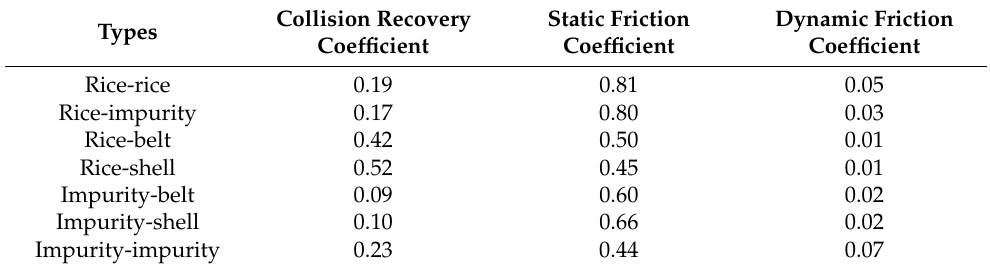
Table 2. Contact parameters used in the EDEM for grain contact model simulation.